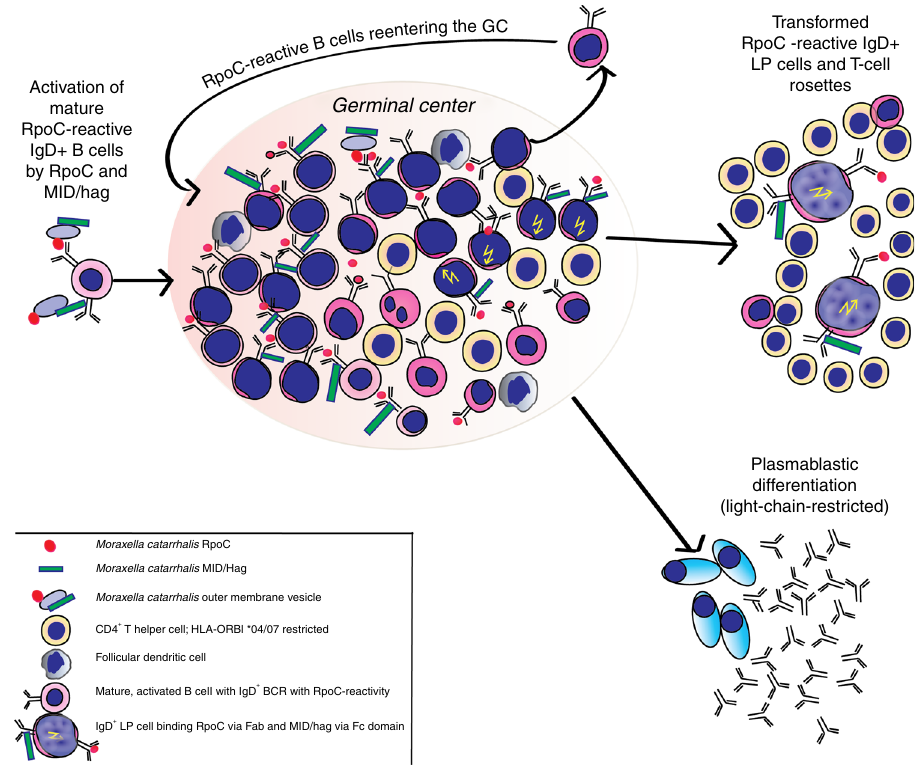
Fig. 4 Presumable role of M. catarrhalis in the pathogenesis of IgD + NLPHL. Costimulation of B cells characterized by IgD + BCR and extraordinary long CDR3s by M. catarrhalis RpoC via the Fab fragment and MID/hag via the Fc fragment of their BCR. Naïve, mature IgD + B cells with a BCR speci fi c for RpoC encounter M. catarrhalis outer membrane vesicles. Binding of RpoC to the Fab and of MID/hag to the Fc region of membranous IgD induces activation of RpoC-speci fi c IgD + B cells, which is supported by CD4 + T cells particularly in patients with an HLA-DRB1*04 or DRB1*07 haplotype. The persistent or recurrent presence of M. catarrhalis presumably induces a germinal center reaction resulting in differentiation to memory B cells and plasmablasts and production of class-switched anti-RpoC serum antibodies and apoptosis of some germinal center cells due to disadvantageous mutations. The co- stimulatory effect of MID/hag through binding to the Fc part of IgD selects for retention of IgD on a fraction of the stimulated germinal center B cells. Meanwhile a clone acquires mutations in proto-oncogenes, tumor suppressor genes as well as chromosomal translocations and may transform into LP cells. However, the transformed IgD + LP cells still gain growth advantage by the interaction of their BCRs with M. catarrhalis RpoC and